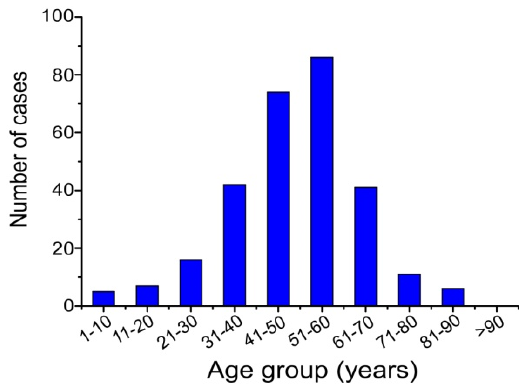
Figure 3. Age distribution of 288 human melioidosis patients from Hainan, China, 2002–2014.